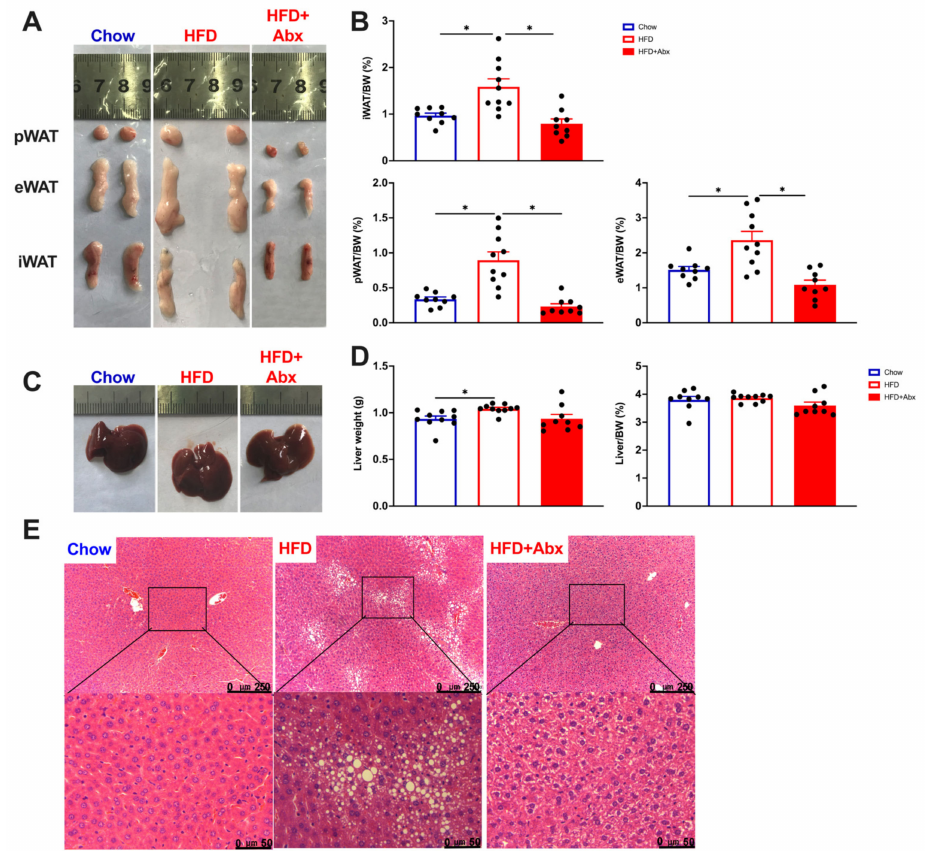
Figure 6. Gut microbiota depletion reduced fat deposition in HFD-fed mice. ( A ) Representative pictures for mice in the Chow, HFD, and HFD+Abx groups; ( B ) the ratios of iWAT, pWAT, and eWAT to body weight; ( C ) representative pictures for liver in mice from the Chow, HFD, and HFD+Abx groups; ( D ) liver weight and the ratio of liver to body weight; ( E ) representative pictures for H&E- stained liver sections. iWAT, inguinal white adipose tissue; pWAT, perirenal adipose tissue; eWAT, epididymal white adipose tissue. Small black squares are magnified in the bottom. Data were expressed as the mean ± SEM. * p <